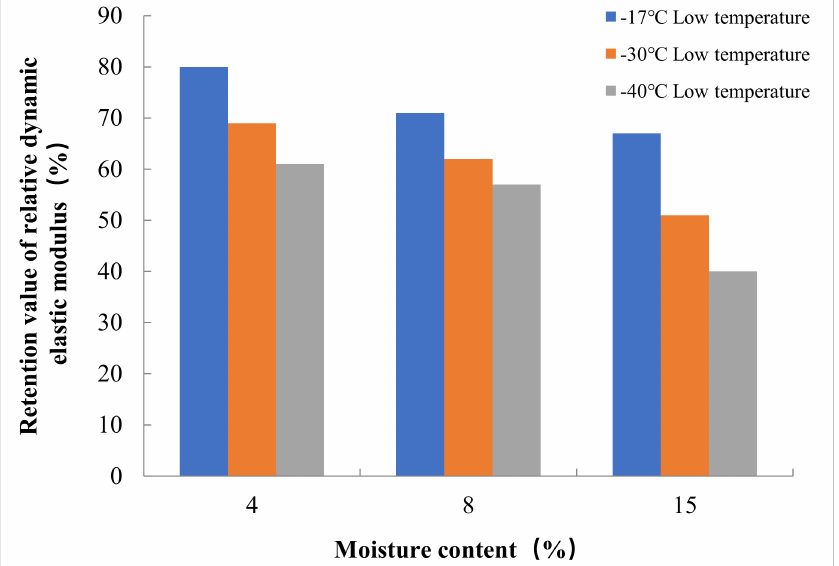
Figure 6. Relationship between internal moisture content and relative dynamic elasticity modulus retention value of concrete for freeze–thaw cycle